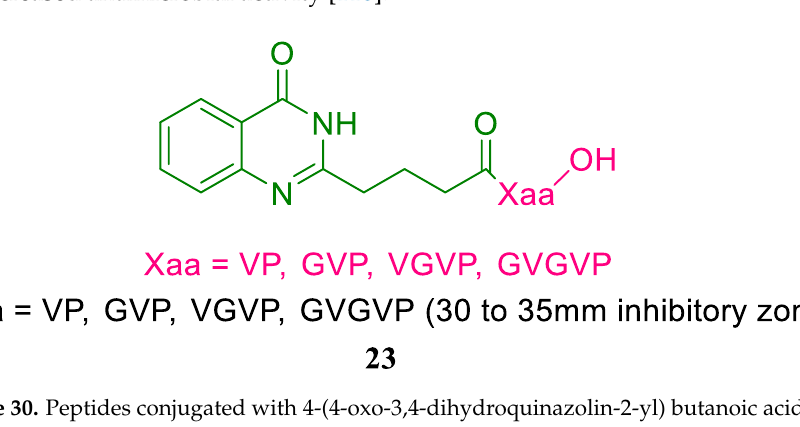
Figure 30. Peptides conjugated with 4-(4-oxo-3,4-dihydroquinazolin-2-yl) butanoic acid. Singh I P et al. synthesised amino acids conjugated to piperoyl derivatives ( 24 ) and evaluated them as antileishmanial agents (Figure 31). The authors used alkaline hydrolysis to convert piperine into piperic acid. Another method they used involved preparing piperic acid by the direct saponification of the chloroform extract of P. nigrum , which was treated with methanesulfonyl chloride in dry CH 2 Cl 2 to yield piperic acid mesylate. These, upon reaction with amino acid methyl esters, resulted in piperoyl-amino acid methyl ester conju- gates. All the compounds exhibited superior results for antileishmanial activity against amastigote compared to the promastigote (three-fold lesser). The title compounds with ester function showed high activity against amastigotes, whereas the compounds with acid functional group exhibited maximum effectiveness against promastigotes. Val methyl ester conjugated piperic acid displayed an IC 50 of 0.075 mM and compounds with Met and Trp also showed good activity. The docking study was performed on the synthesised compounds by using Autodock 4.2 programme against the target adenine phosphoribosyl- transferase. The compound containing isopropyl moeity showed H-bonding interaction to Ala150, Thr151, Gly152, Thr154 and Ala155 and docked efficiently in terms of location near AMP and Mg 2+ . Molecular simulation studies suggested that the synthesised compounds were bound to the active site of L. donavani protein 1QBB [117].